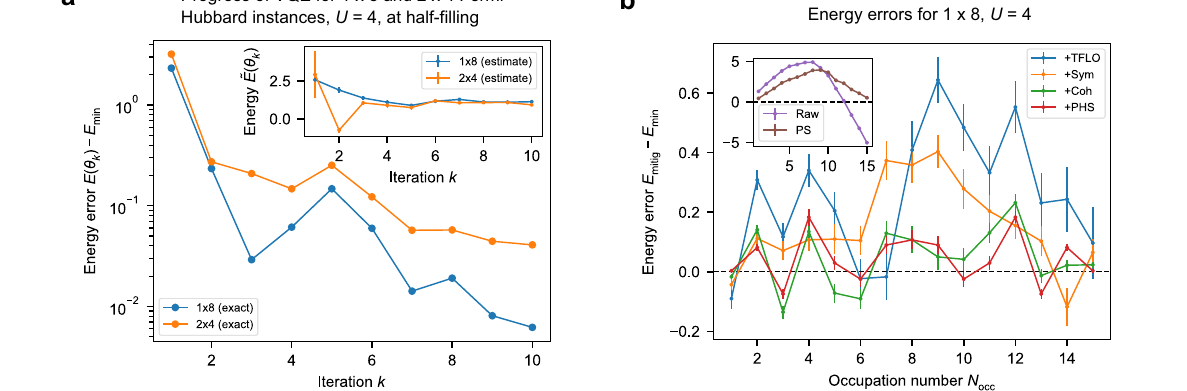
one variationallayer;1×4hastwo variationallayers.Insetshowszoomed-inregion around half- fi lling. d , e Chemical potentials μ for a 1×8 system, where μ ( N occ )= E ( N occ ) − E ( N occ − 1). Inset shows the derivative μ 0 ð N occ Þ = E ð N occ +1 Þ(cid:1) 2 E ð N occ Þ + E ð N occ (cid:1) 1 Þ of the chemical potential at even occupations. f Decay of normalised charge correlations C c ð 1, i Þ = ðh n 1 n i i(cid:1) h n 1 ih n i iÞ = ðh n 2 1 i(cid:1) h n 1 i 2 Þ for even occupationnumbers.Solidlines:experimentalresults.Dashedlines:correlationsin ground state. Error bars were calculated according to the procedure described in Methods section and are often too small to be